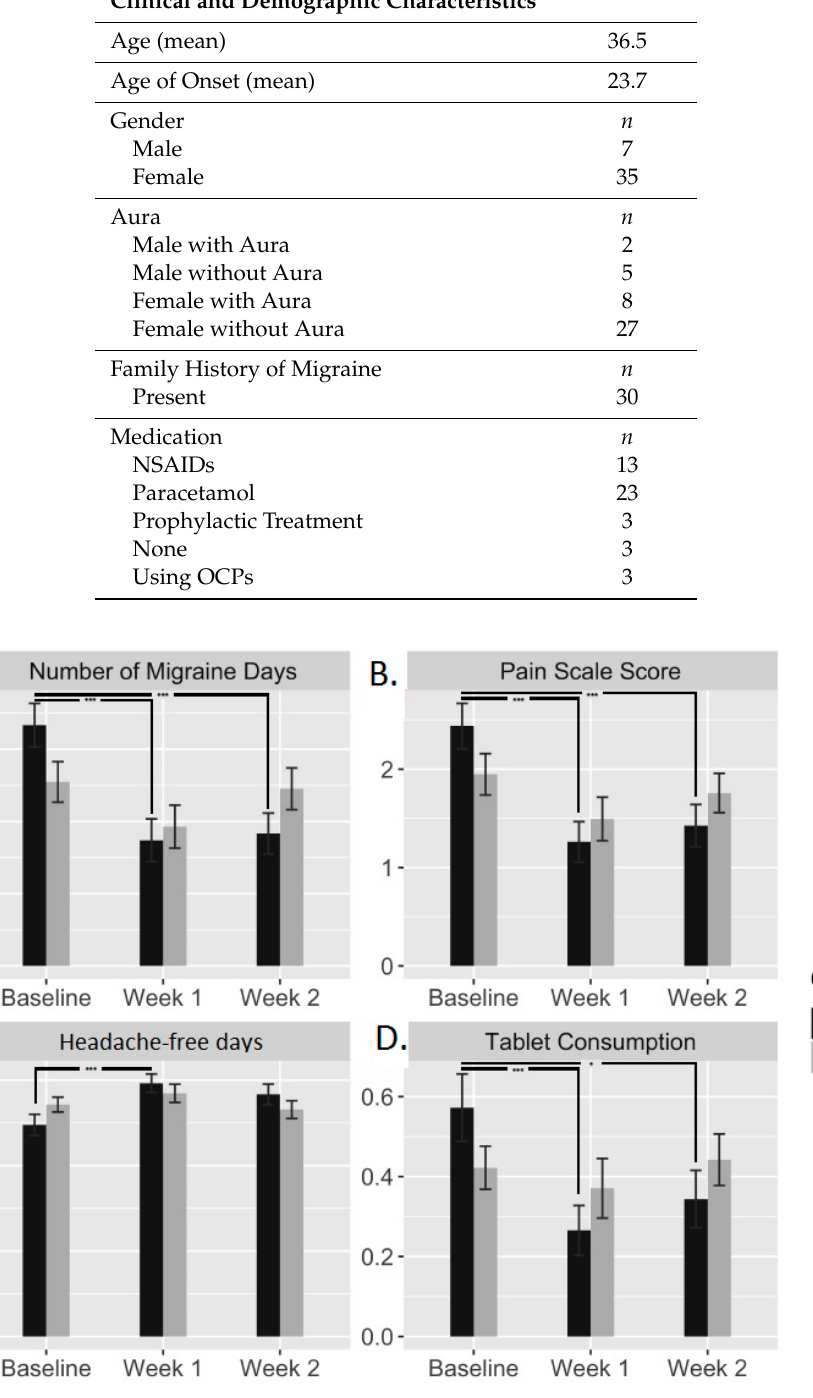
Figure 2. The bar plots represent the mean ± standard error of the mean (SEM) of the four output measures before (baseline) and after (week 1 and week 2) active and sham conditions. These output measures are ( A ) number of migraine days, ( B ) pain scale scores (VAS), ( C ) headache-free days and ( D ) tablets consumption. *** indicates a significance <0.001; * indicates a significance <0.05.